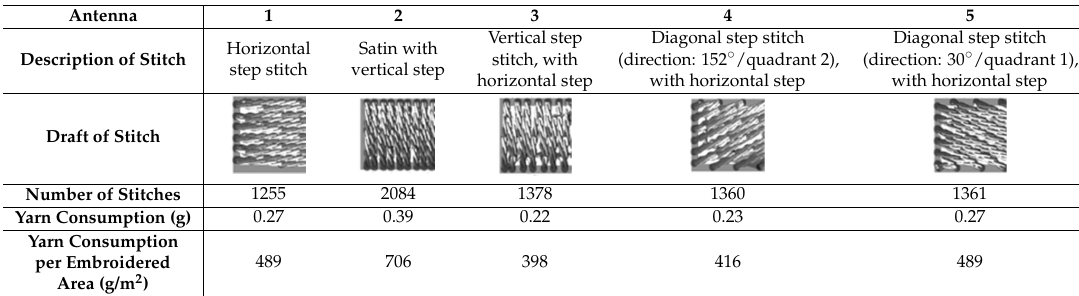
Table 4. Parameters of the embroidered antennas.